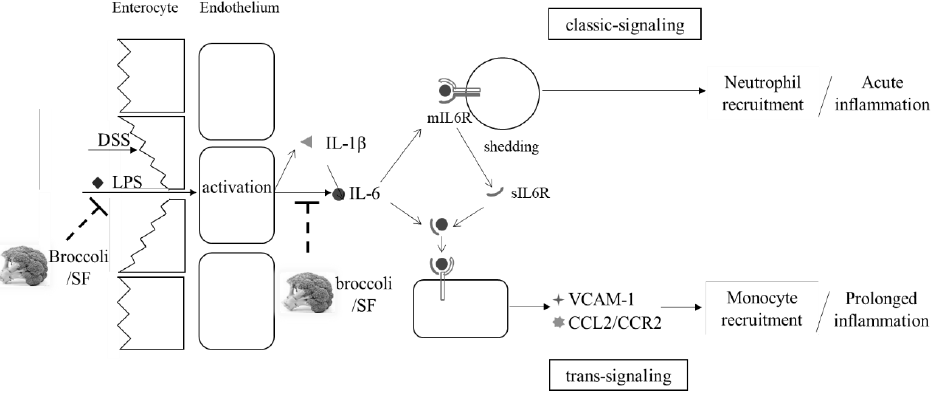
Figure 7. Proposed molecular mechanism of anti-inflammatory property of broccoli is through the IL-6 trans-signaling pathway. trans-signaling